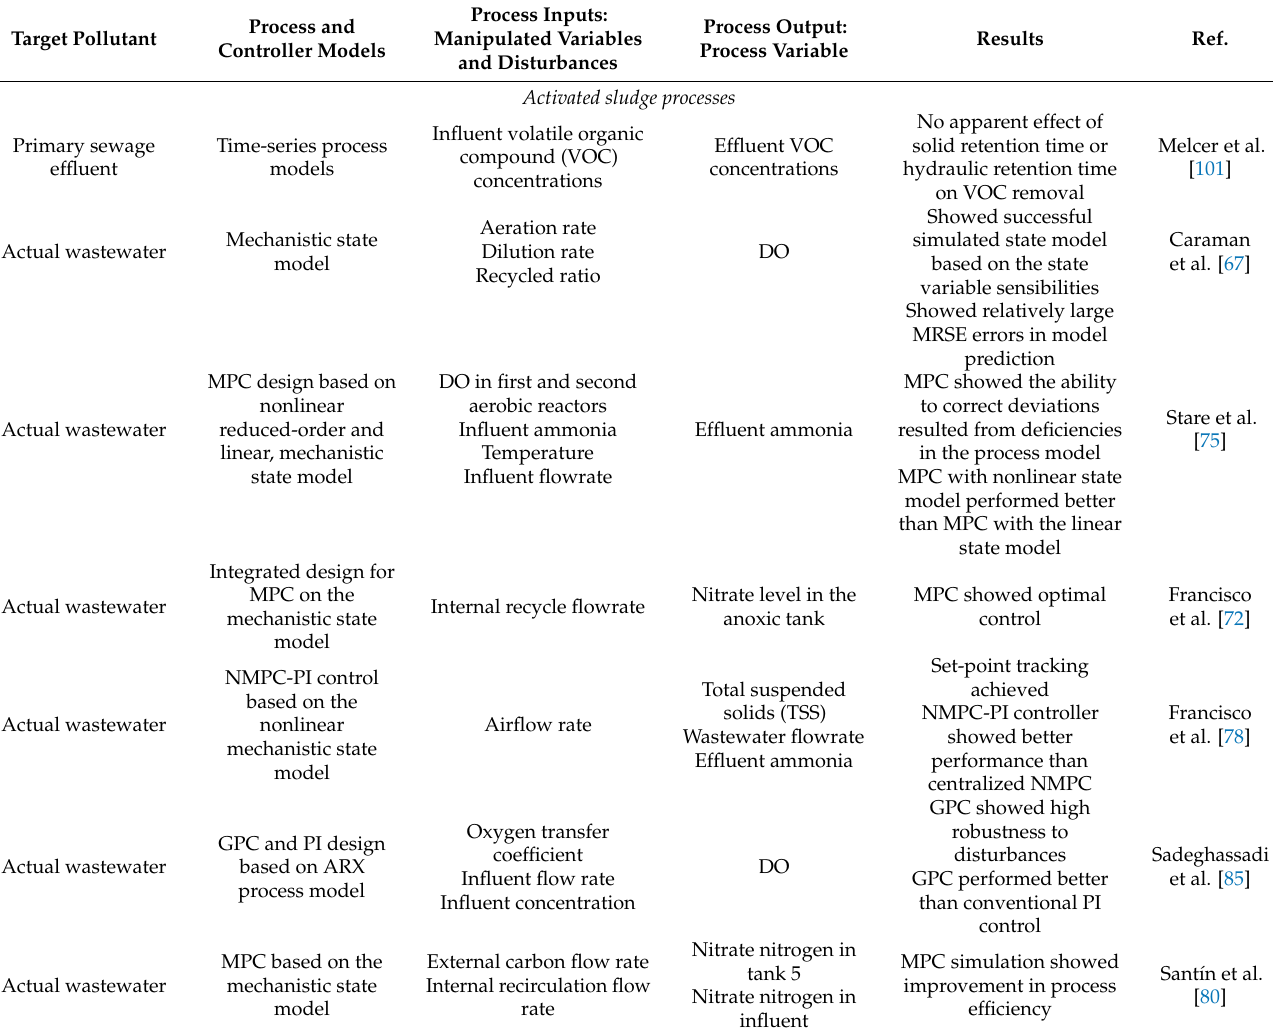
Table 4. Dynamic process model and process control strategies of wastewater treatment technologies. Target